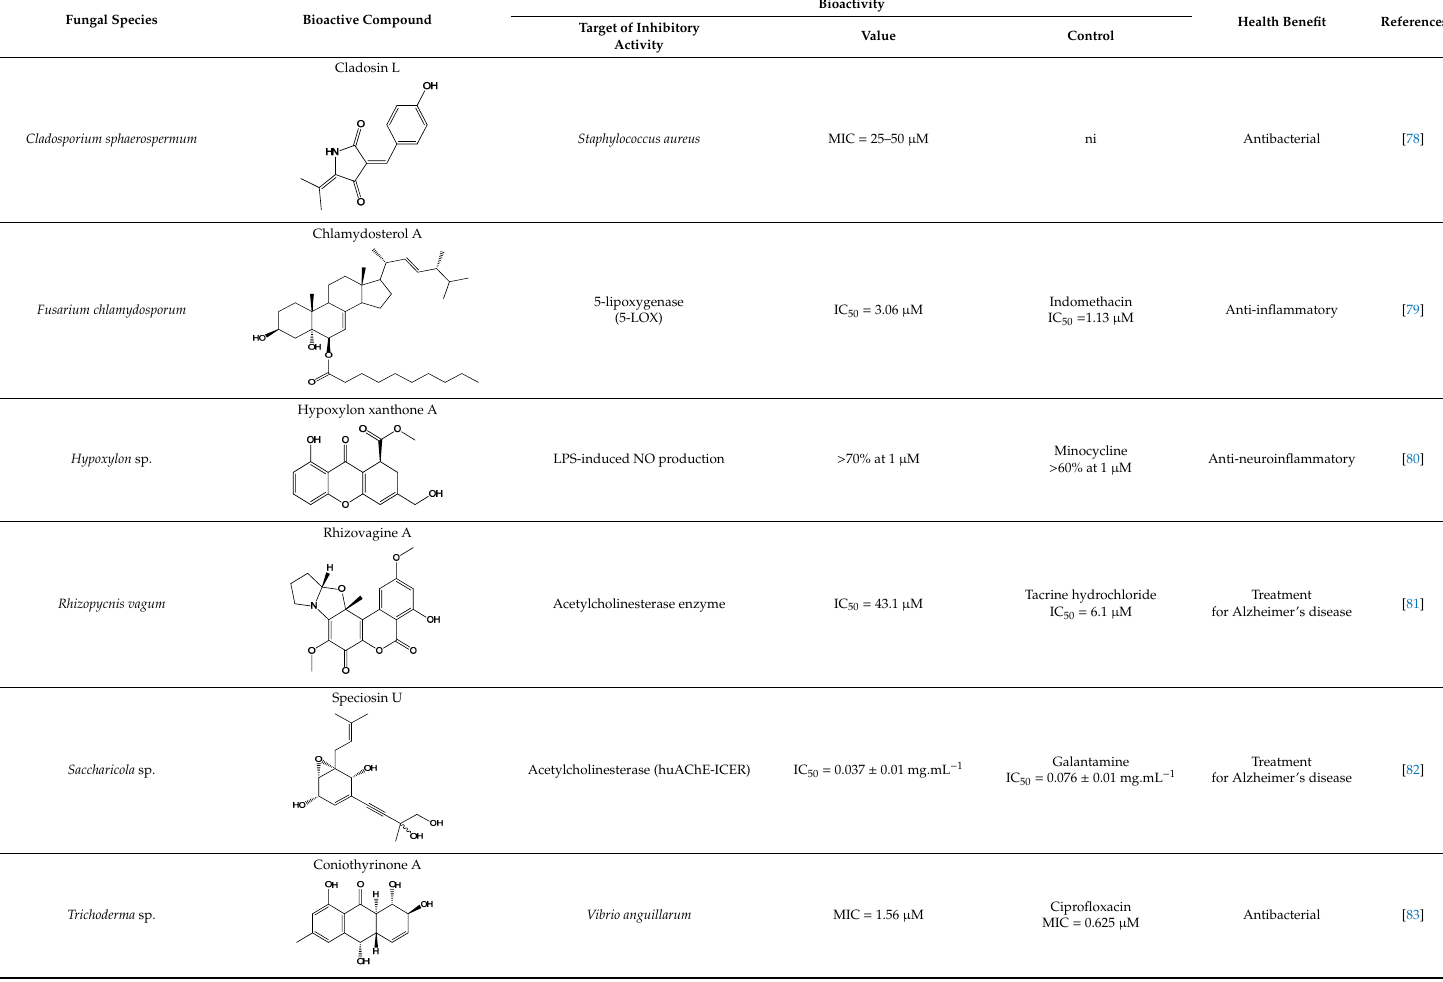
Table 4. Examples of non-cytotoxic biologically active fungal secondary metabolites.